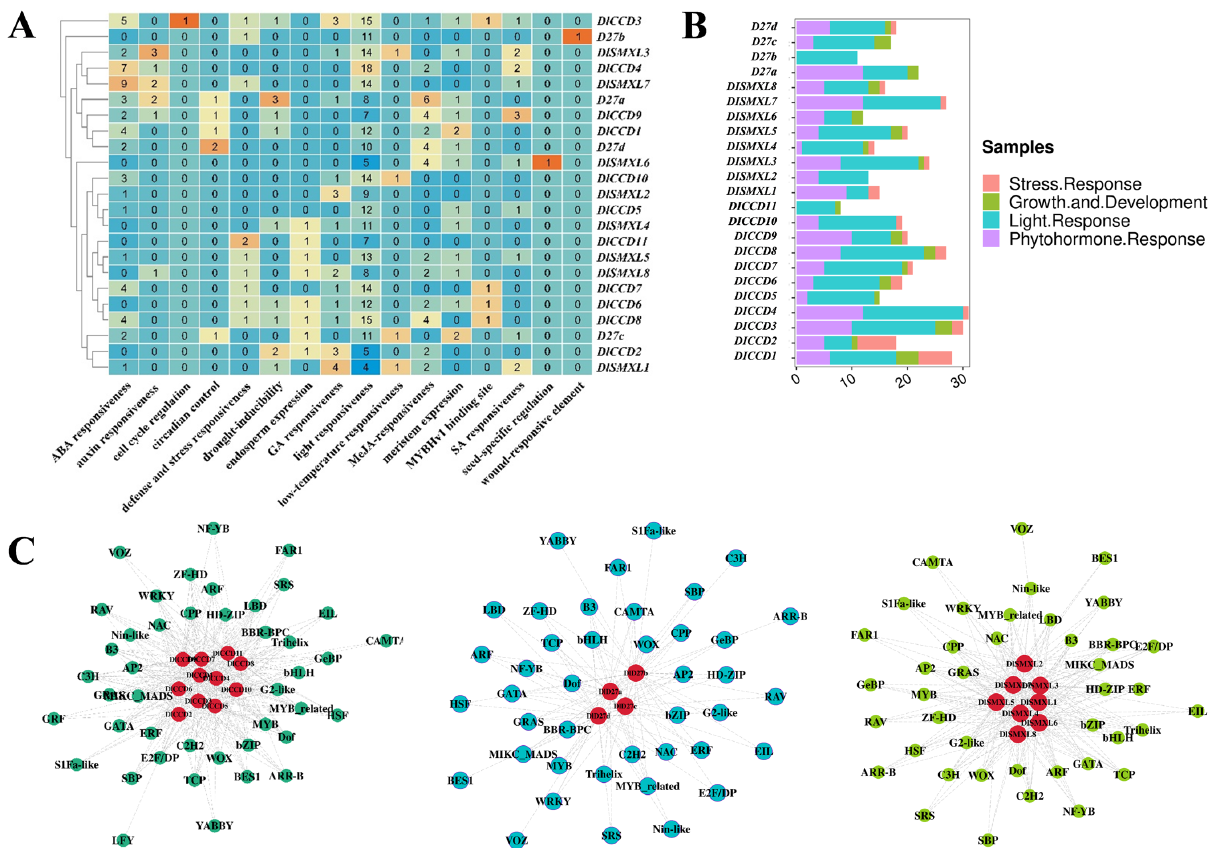
Figure 3. CRE analysis of the promoter region of DlCCD, DlSMXL, and DlD27 genes. ( A ) DlCCD, DlSMXL, and DlD27 family members were arranged in the order of phylogenetic tree. The names of CREs were marked on the bottom. The heatmap shows the number of main CREs corresponding to each member. ( B ) CREs were classified into four categories: stress response, growth and development, light response, and phytohormone response. The bar chart counts all the number of four types of CREs in each member, and different types of CREs are indicated by different colors. ( C ) Network diagram of predicted transcription factor binding sites with DlCCD, DlSMXL, and DlD27 family members. Gray connecting lines indicate the presence of interactions.